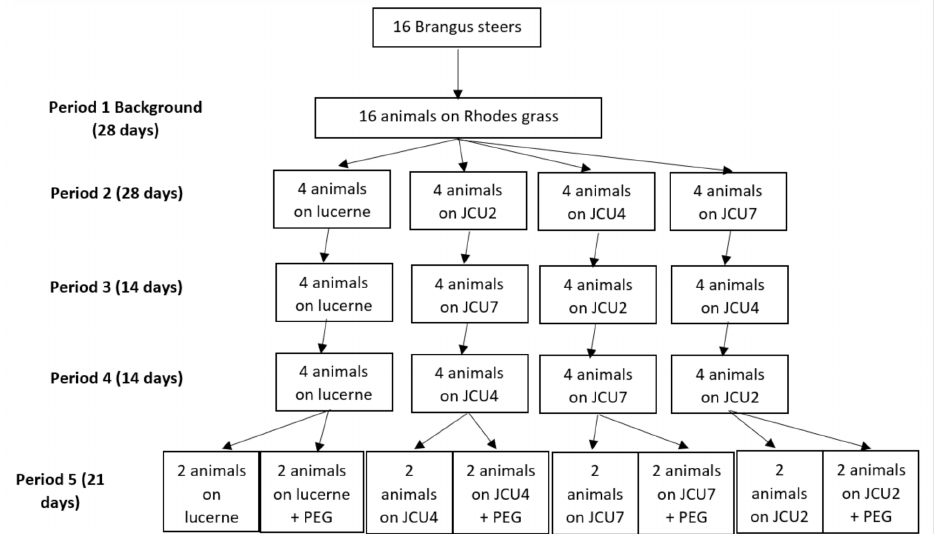
Figure 1. The experimental